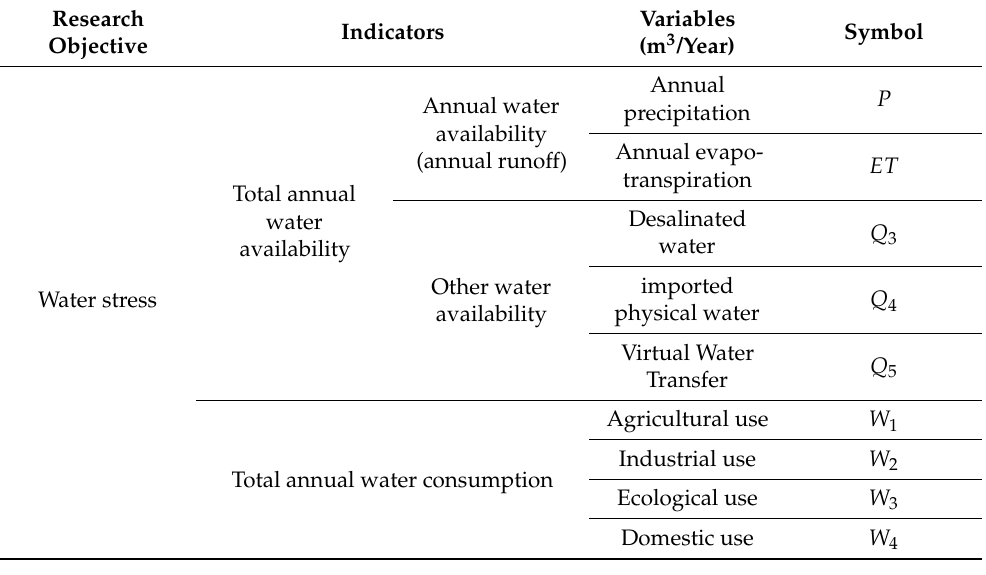
Table 2. Indicators to assess water stress with virtual water